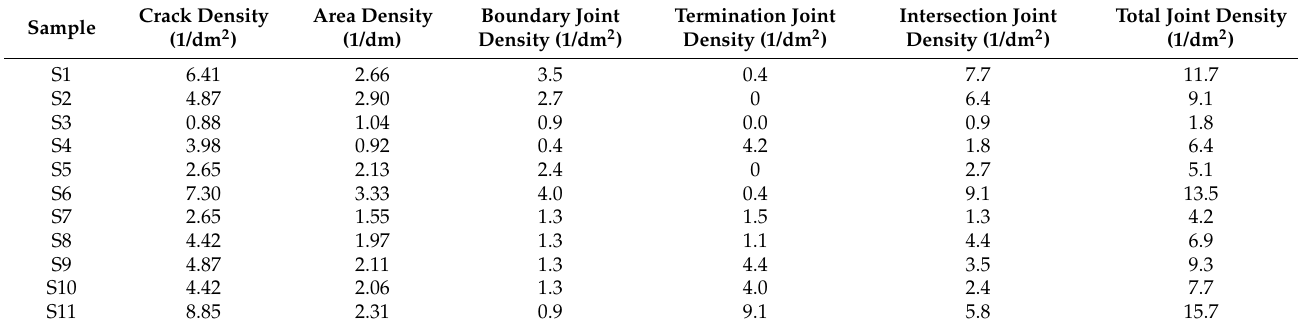
Table 8. Morphological parameters of samples at the scale of per dm 2 .